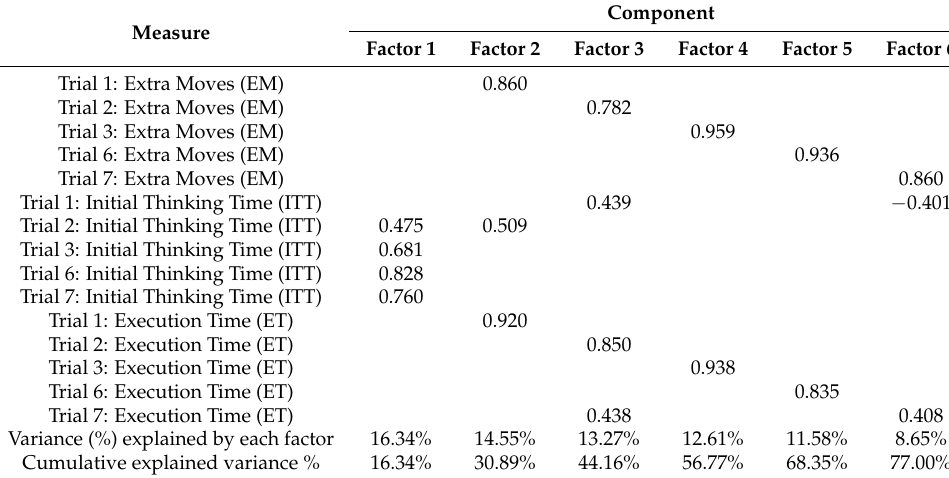
Table 8. Factor loadings of five trials of Tower of London